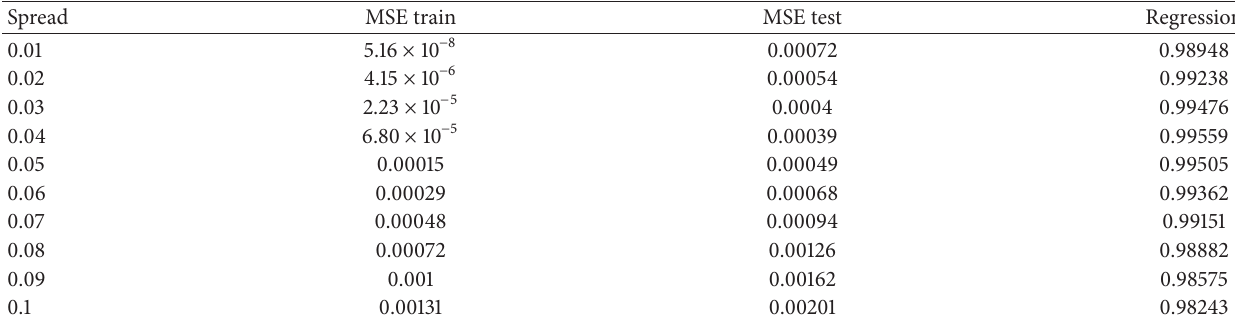
Table 3: The GRNN comparison for different spreads.